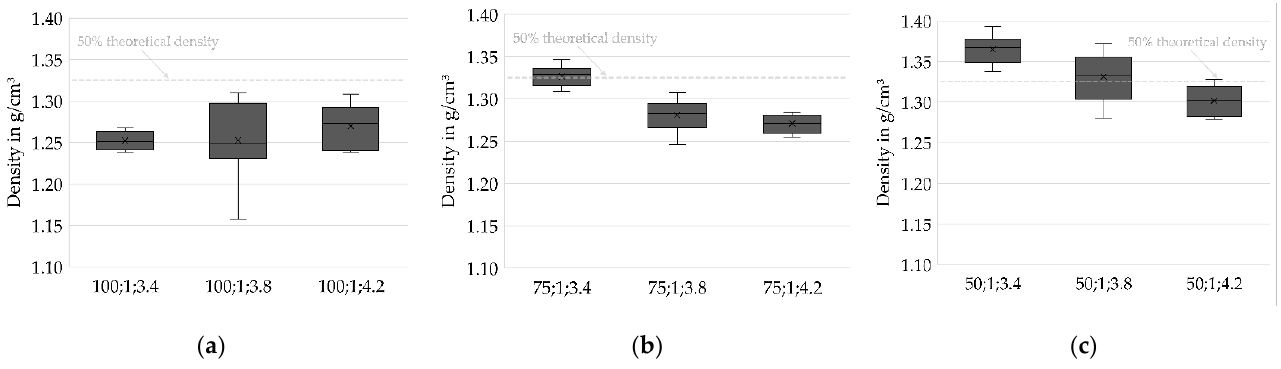
Figure 8. Density distributions for different layer heights. Higher drying intensities result in reduced densities for h = 75 µm and h = 50 µm. For h = 100 µm, no trend can be deduced. ( a ) h = 100 µm, n = 8; ( b ) h = 75 µm, n = 8; ( c ) h = 50 µm, n = 8.